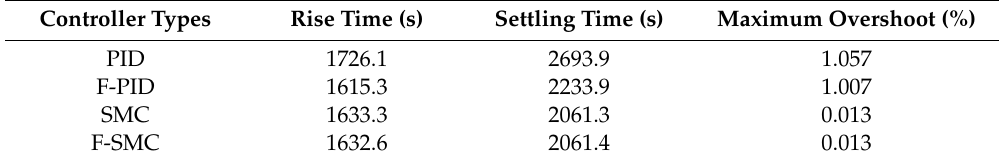
Table 9. Changes of characteristic parameters.